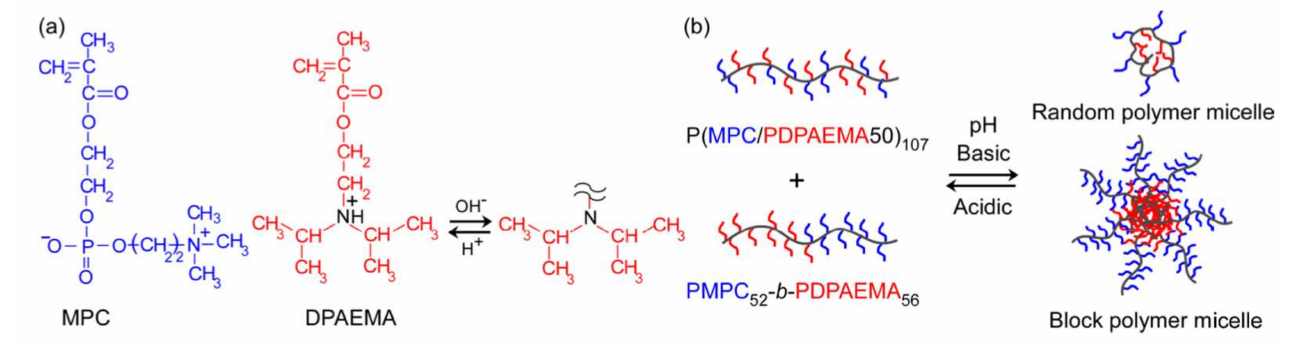
Figure 1. ( a ) Chemical structures of MPC and DPAEMA, and pH-responsive behavior of DPAEMA. ( b ) Conceptual illustration of the pH-induced formation of separated micelles in a mixed aqueous solution of the random and block copolymers consisting of MPC and